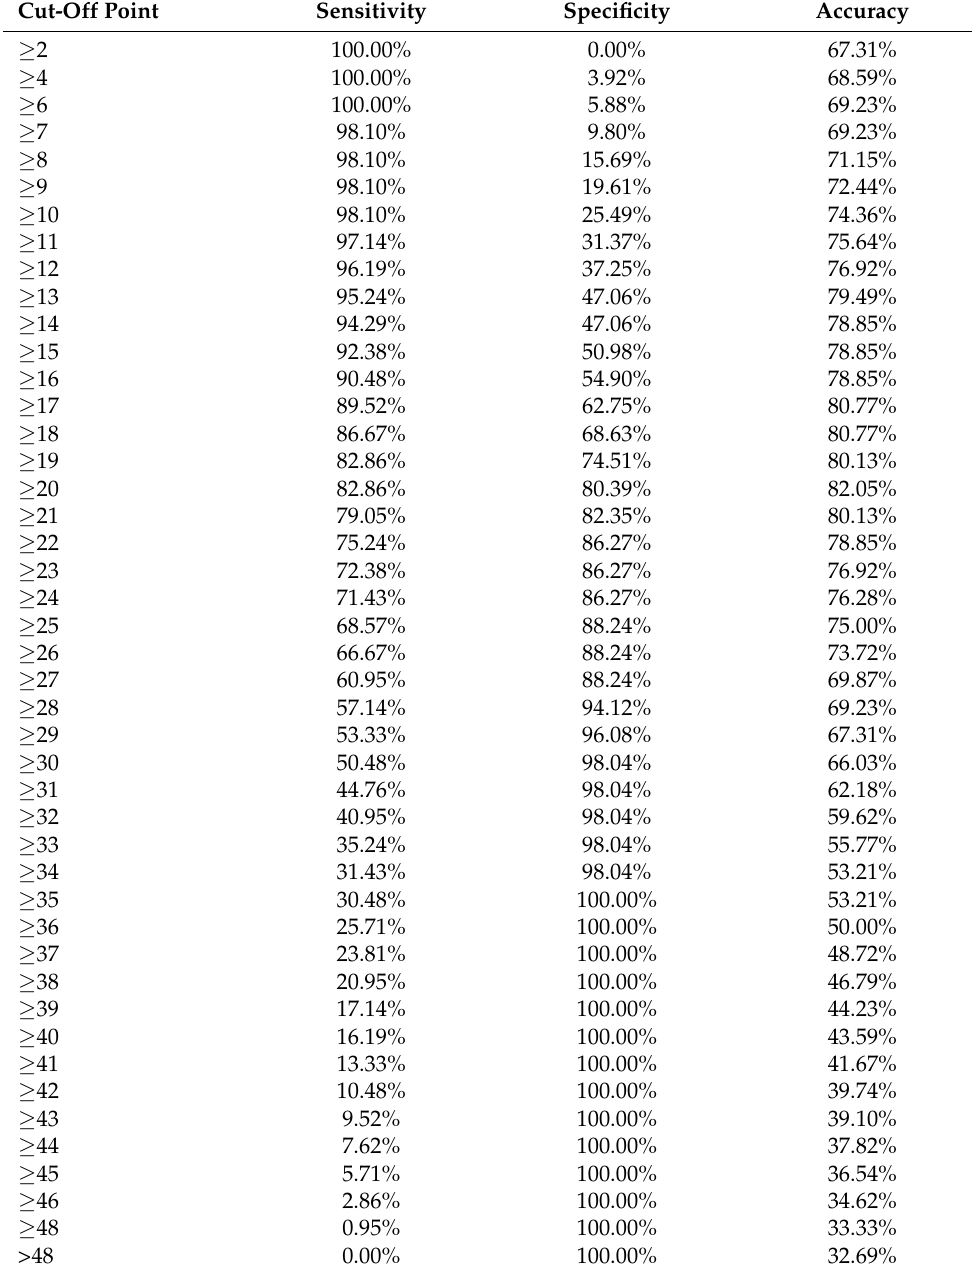
Table 3. Characteristics of the cut-off points for TDAS according to the DSM-5 ASD